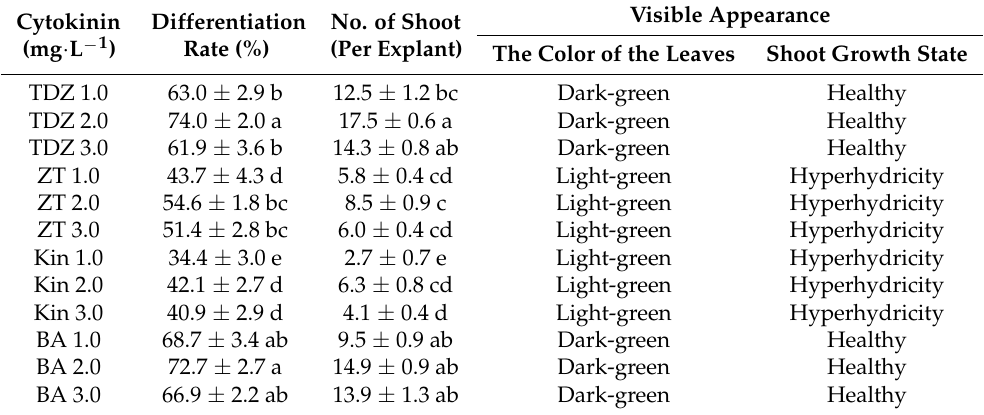
Table 1. Effect of cytokinins on direct adventitious shoot regeneration of Sinningia hybrida ‘Isa’s